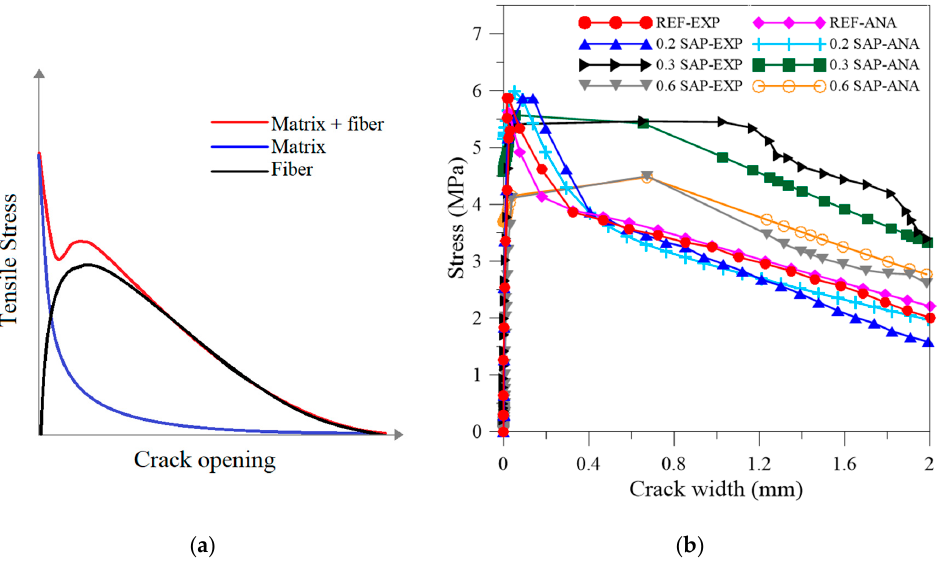
Figure 9. ( a ) Typical stress versus crack opening after cracking for the fiber–matrix composite. ( b ) Analytical model with experimental results for the SFRC with SAP additions. 419